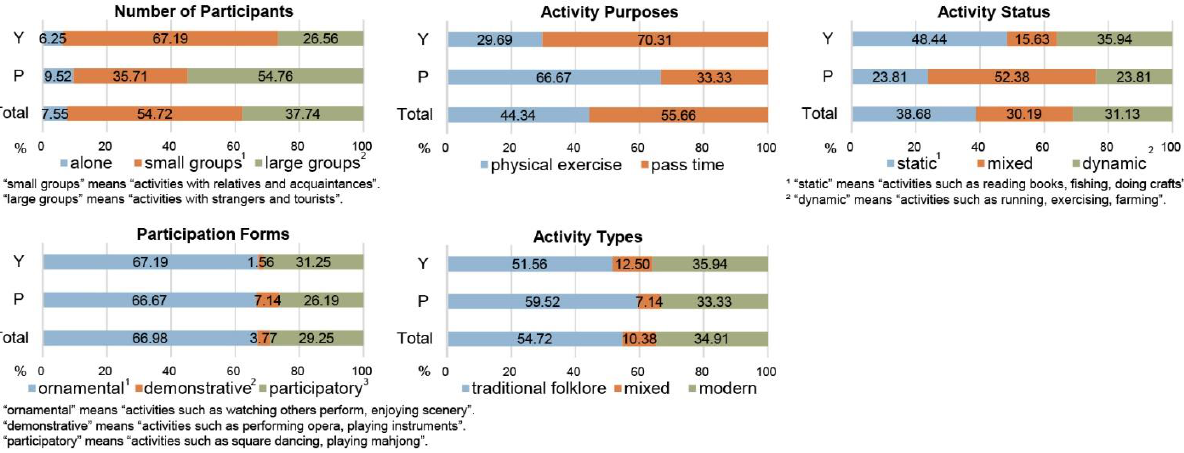
Figure 9. Survey statistics of respondents ’ activity contents preferences.